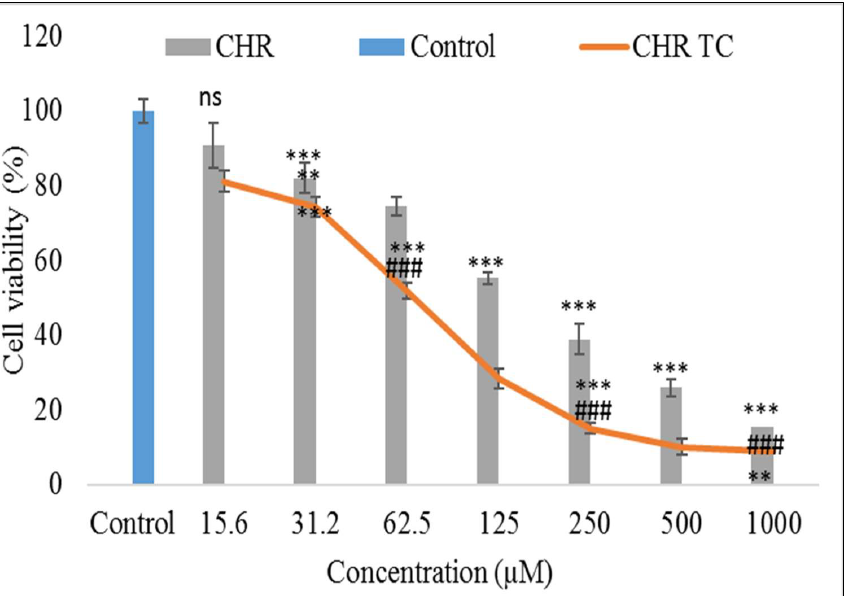
Figure 7. Cell viability study of pure Chrysin (CHR) and Chrysin ternary complex (CHR-TC) against breast cancer cell line (MCF-7). The study was performed three times, and data was shown as mean ± SD. *** highly significant to control; ** significant to pure Chrysin; ### highly significant to pure Chrysin; ns- nonsignificant.